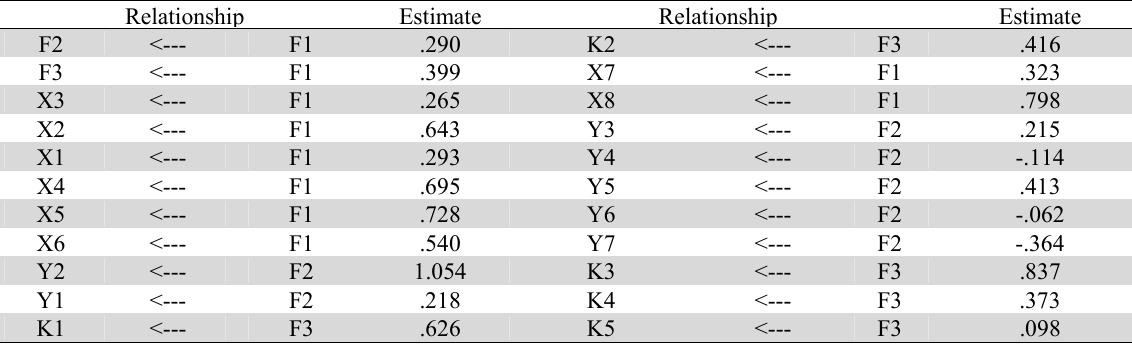
Standardized Regression Weights: (Group number 1 - Default model)